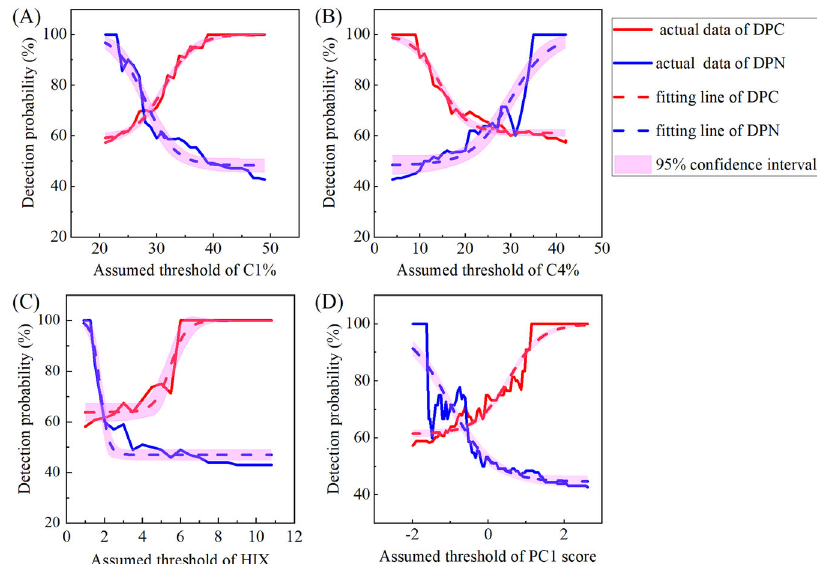
Fig. 4 The relationships between screening indices and DPC and DPN. Red lines indicate the DPC, and blue lines indicate DPN. The detection probability of the solid lines was calculated using the set arithmetic sequence as the threshold, while the dashed lines were the fi tting results of solid lines; and the pink bands were the 95% con fi dence interval of the fi tting